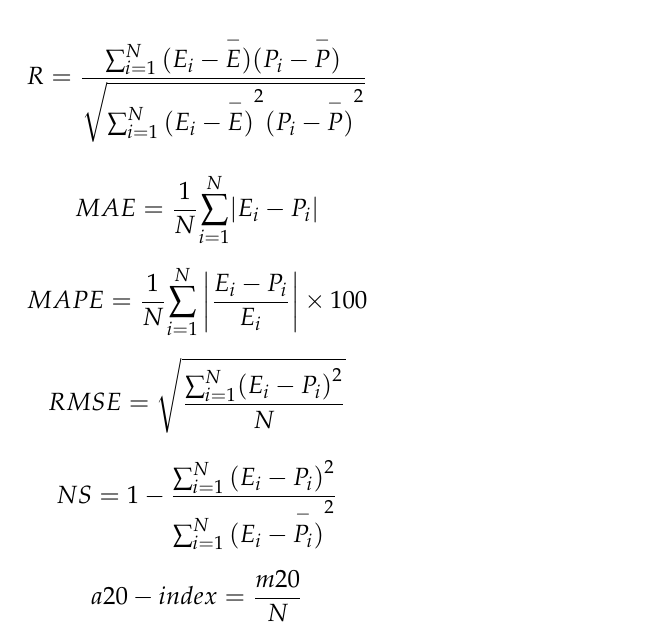
Figure 2. Heat plot of input and output parameters.